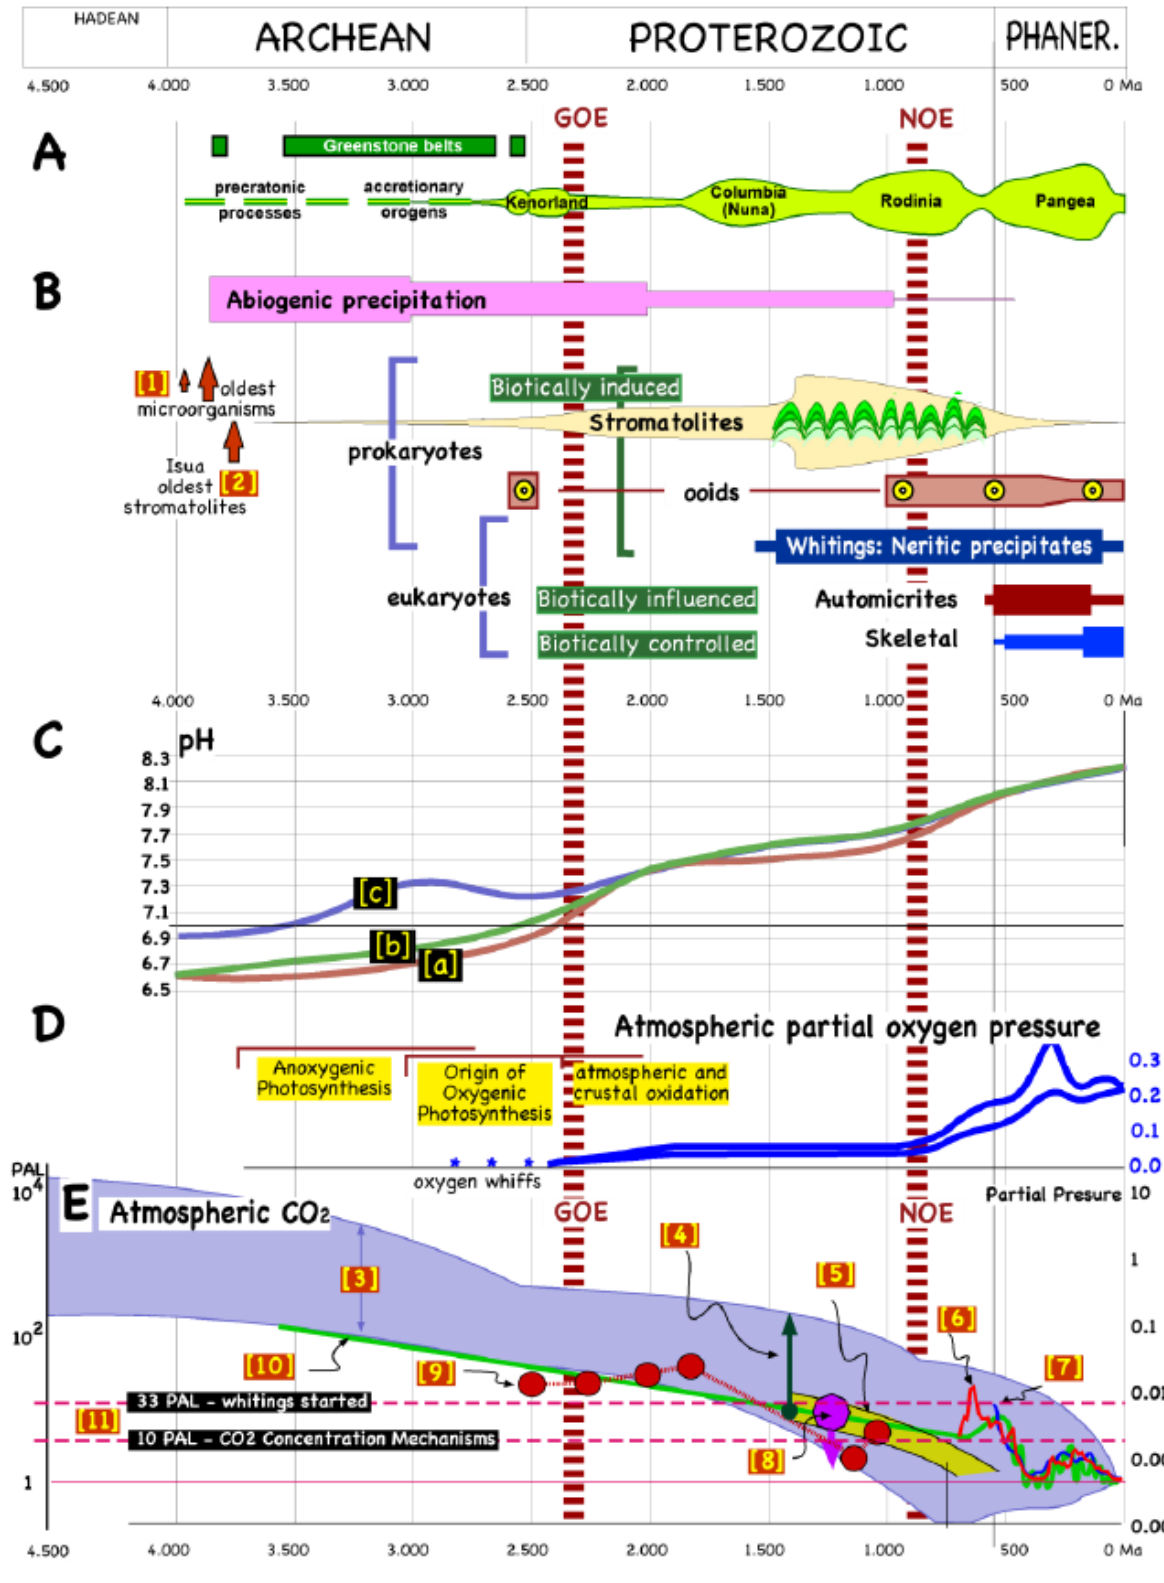
Figure 2. Carbonate precipitation nodes, genetic macroevolution rates, and estimates of oxygen and CO 2 in the atmosphere. ( A ): Supercontinents and crustal growth; precratonic, accretionary orogens and supercontinents assembly (redrawn from multiple sources). ( B ): Carbonate precipitation modes through Earth’s history (multiple sources). [1]: Oldest fossils [18]. [2]: Isua oldest s tro-